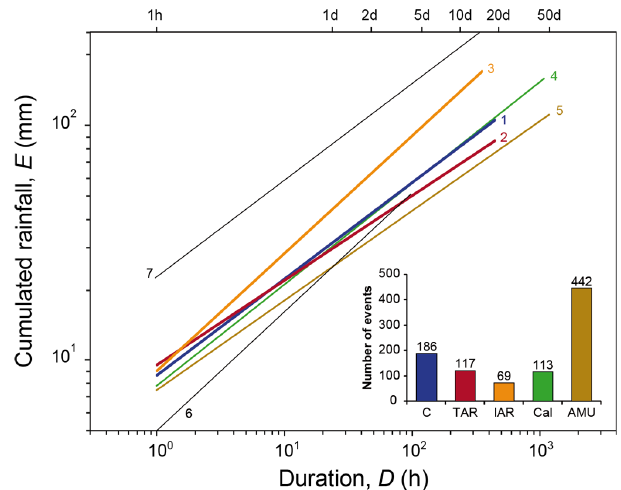
Fig. 11. Cumulated event rainfall – rainfall duration ( ED ) thresholds for shallow landslides in Calabria: T 5,C (line 1), T 5,TAR (line 2), T 5,IAR (line 3), T 5,Cal (line 4). T 5,Cal is the 5% frequentist thresh- old proposed for Calabria by Brunetti et al. (2013). T 5,AMU (line 5) is the 5% frequentist threshold proposed for Abruzzo, Marche and Umbria (central Italy) by Peruccacci et al. (2012). Black line 6 is the global threshold for debris flow occurence of Innes (1983). Black line 7 is the global threshold of Kanji et al. (2003). Bar chart shows the number of rainfall events that have resulted in landslides in different study areas in Italy. Equations for the thresholds are listed in Table